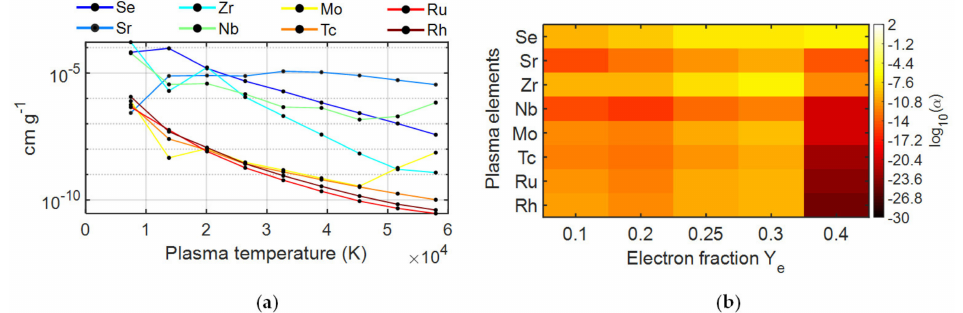
Figure 9. ( a ) Mean opacity (in cm · g − 1 ) vs. plasma temperature (at n 0 = 10 12 cm − 3 ) assuming a plasma emission spectrum arising from numerical radiative transfer equation simulations. ( b ) Weighted mean opacity ( α ) for r-process element abundances (elements vs. neutron richness) at kT = 0.65 eV and n 0 . The weighting was performed by using relative abundances of species resulting from SKYNET [36] nuclear network calculations of r-process nucleosynthesis yields as a function of Y e